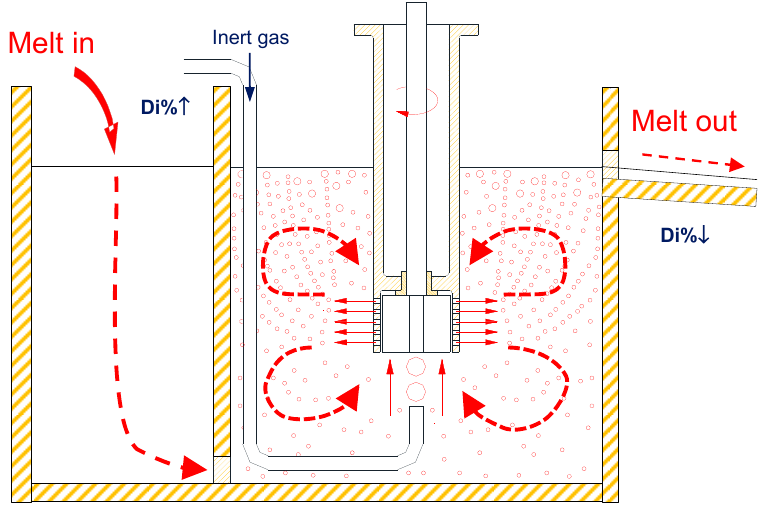
Figure 13. Schematic diagram of the HSMC degassing technology configuration when implemented for continuous in-line processing of aluminum melts. The arrows indicate the flow pattern of the melt and the bubbles in the chamber. Reprinted with permission from [28]. Copyright 2022 Elsevier.